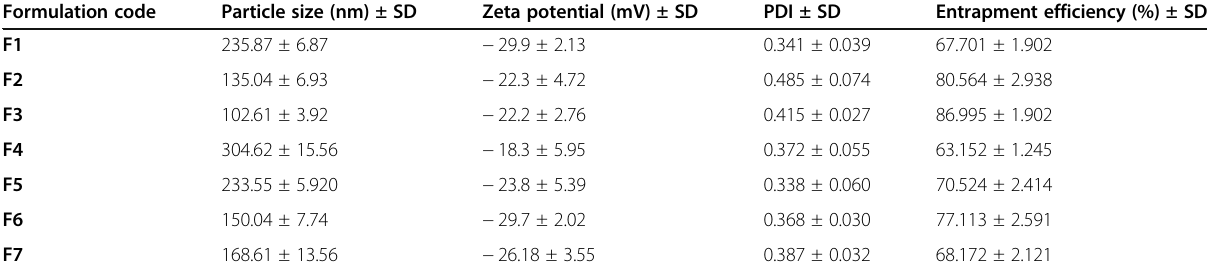
Table 2 Data showing particle size distribution, zeta potential and entrapment efficiency in different nanoparticle formulation Formulation code